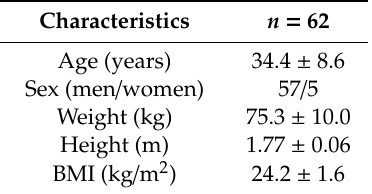
Table 1. Characteristics of the study